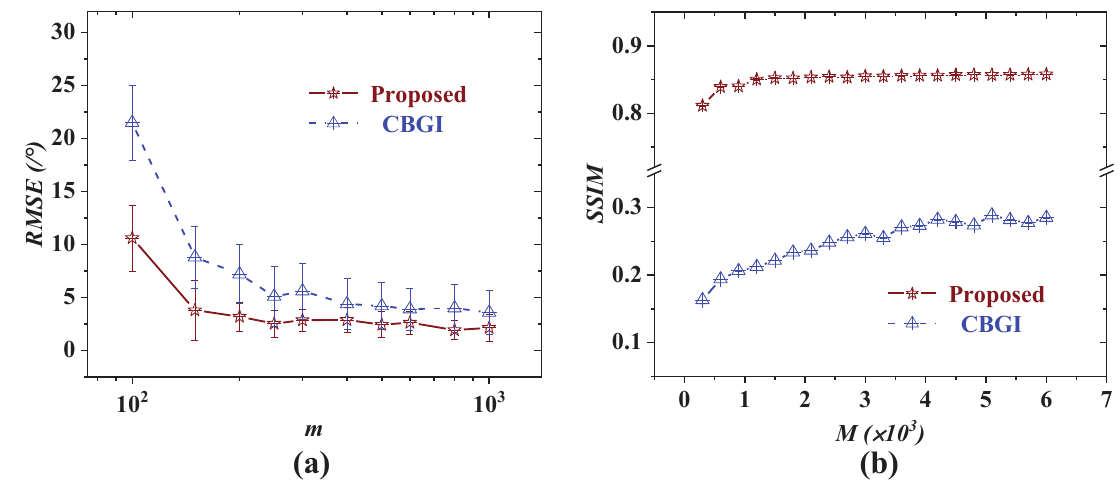
Figure 5. Comparing the performance of different methods on ( a ) the RMSE of the estimated rotation angle against the measurement number m per image period; ( b ) SSIM of the reconstructed images against the total measurement number M